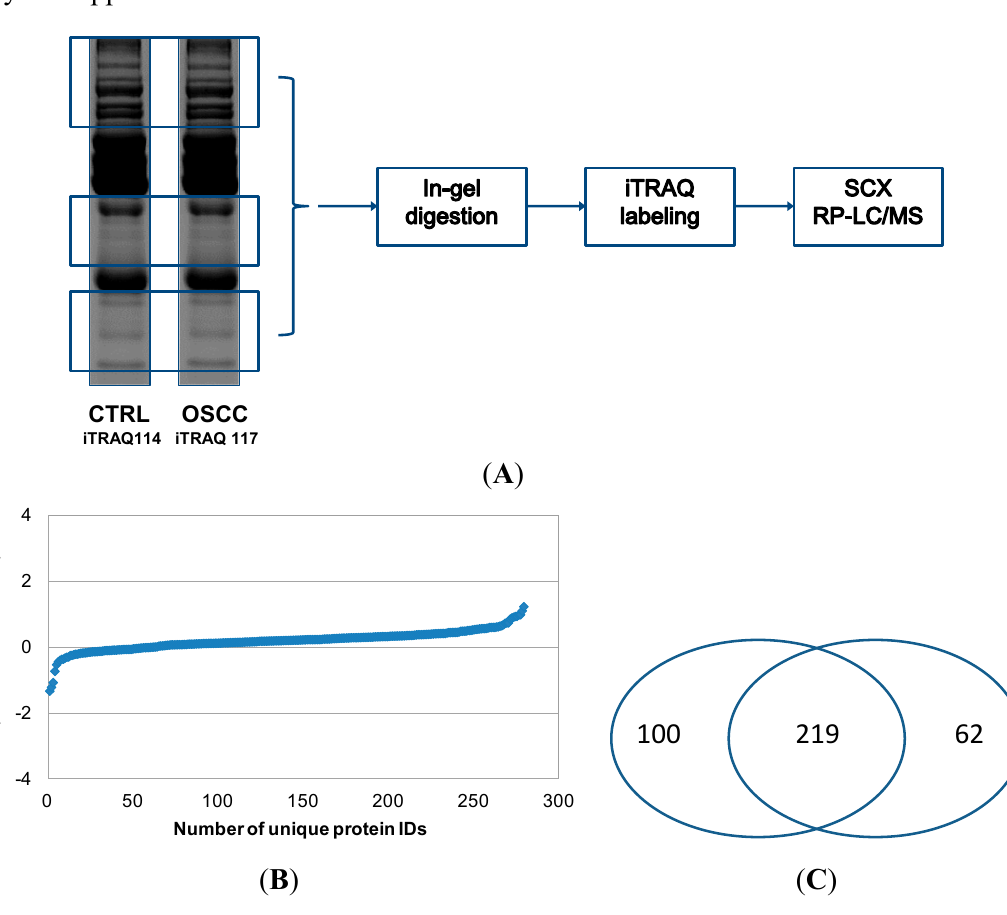
Figure 3. Quantitative proteomic analysis of serum proteins from OSCC patients with Approach 2. In Approach 2, both OSCC and control protein samples were initially separated with SDS-PAGE. Highly abundant proteins within 50–70 kDa and around 28 kDa were avoided, and the rest of proteins were excised for in-gel tryptic digestion ( A ); The resulting peptides were then labeled with iTRAQ tags, respectively, combined and fractionated with SCX. Afterwards, the SCX fractions were analyzed by reversed phase LC (RP-LC) with MS/MS. The number of proteins quantified by Approach 2 and their relative levels between OSCC and healthy control subjects are presented in ( B ); The pie chart shown in ( C ) indicates that most of the proteins are identified and quantified by both analytical